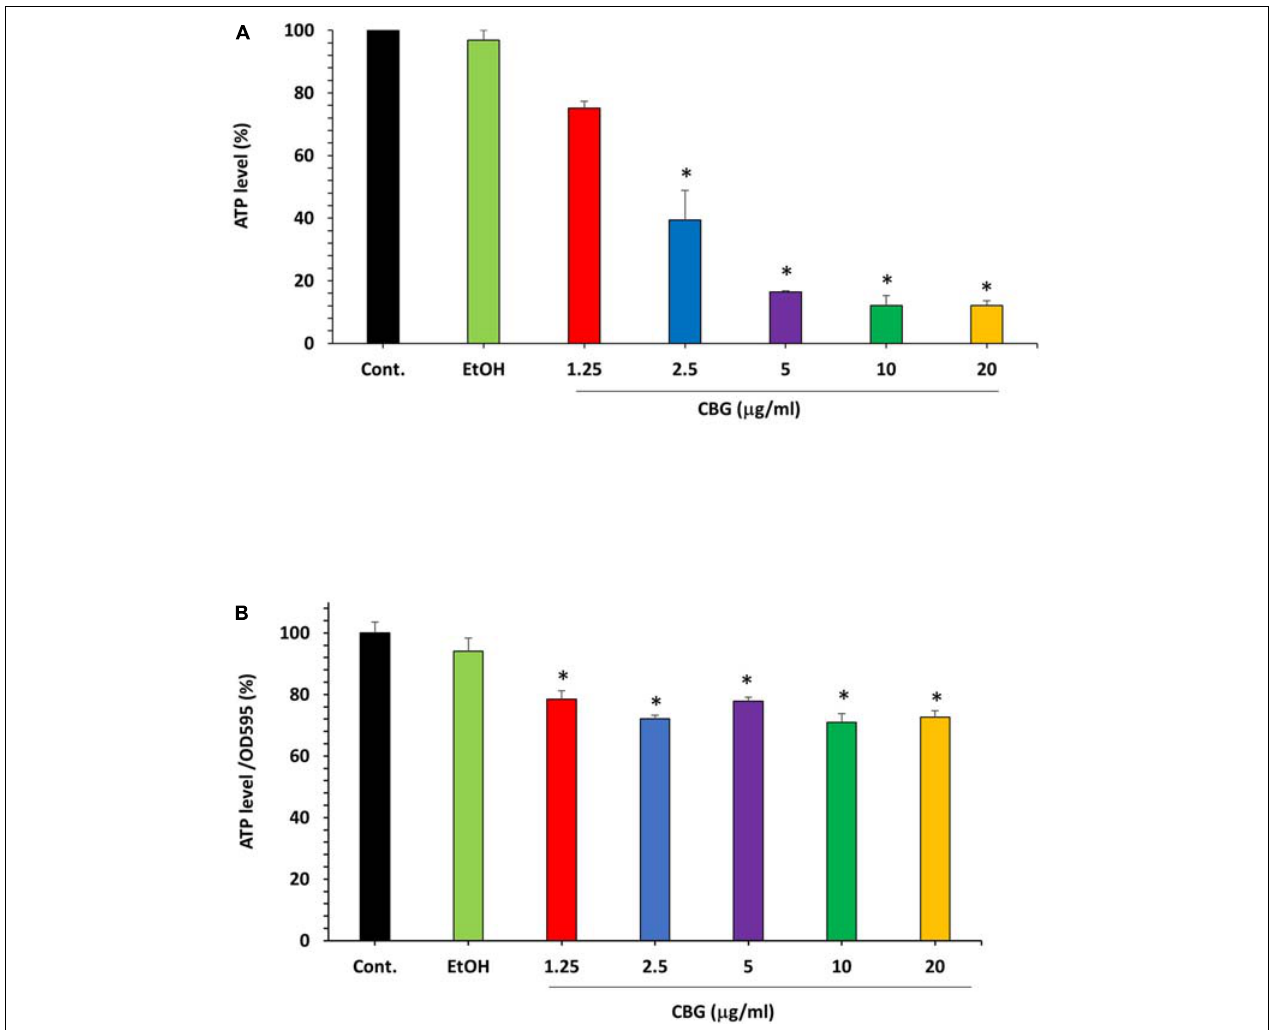
FIGURE 5 | The effect of CBG on the ATP levels in S. mutans . (A) The percentage ATP levels in S. mutans treated with various concentrations of CBG (0–20 µ g/ml) for 2 h in comparison to control. n = 3; * P < 0.05. (B) The percentage of the ATP/OD 595 nm normalized levels in S. mutans treated with various concentrations of CBG (0–20 µ g/ml) for 2 h in comparison to control. n = 3; * p <